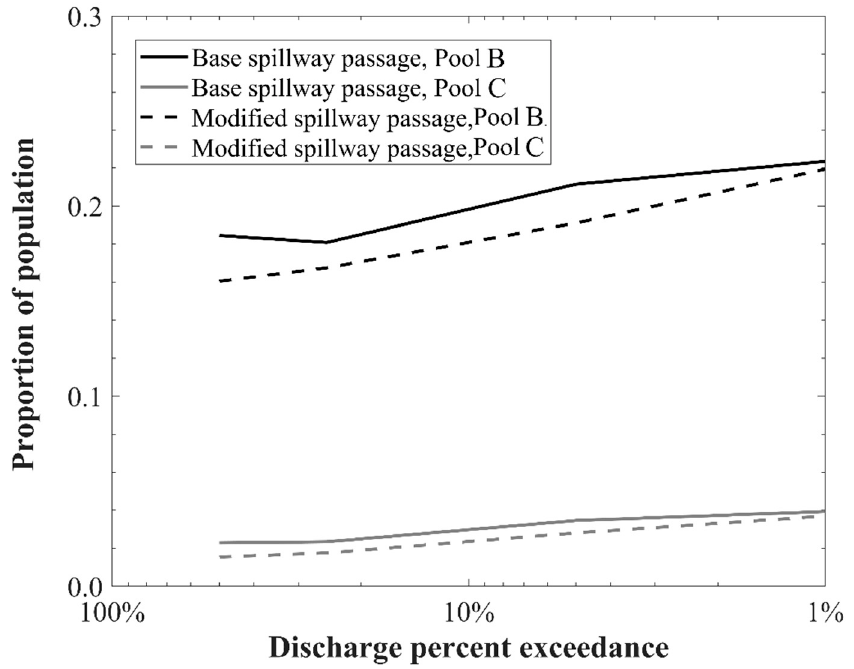
Figure 5. The proportion of silver carp passing a single LD (black lines) or two consecutive LDs (grey lines) under base spillway passage conditions (solid lines) or modified spillway gate conditions as calculated by our FPM (dashed lines).